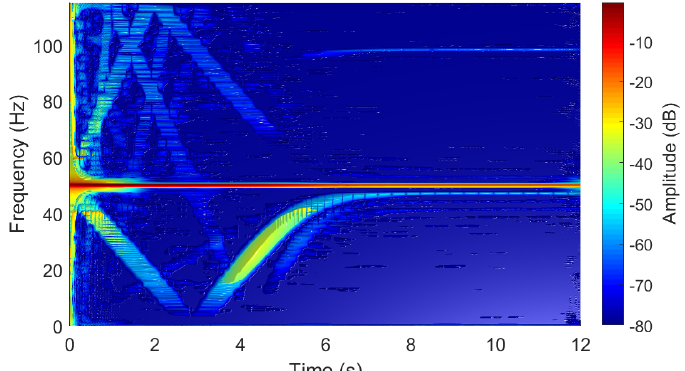
Figure 12. High resolution spectrogram of the current of Figure 8—for each point of the TF region of interest, the minimum value obtained among all the stacked spectrograms of Figure 10, right, is selected. The final result shows with a high resolution both the sinusoidal component at 50 Hz and the lower side band harmonic (LSH) fault